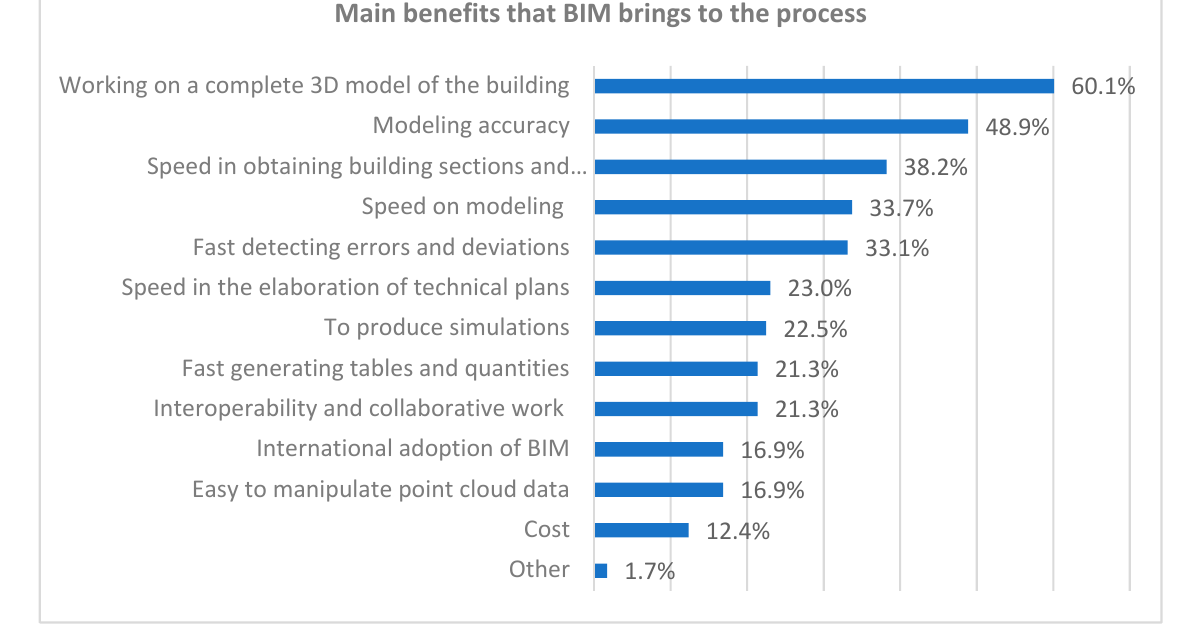
ISPRS Int. J. Geo-Inf. 2021 , 10 , x FOR PEER REVIEW